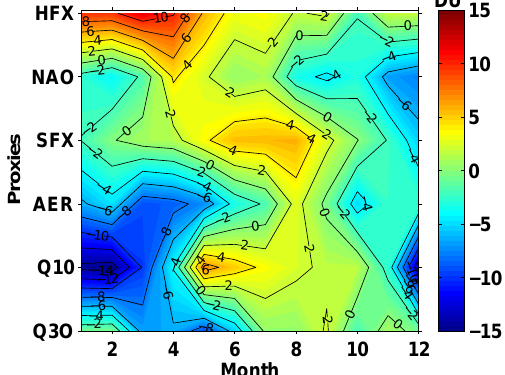
Fig. 2. The influence of individual explanatory variables on the vari- ability of combined Dobson and SAOZ total column ozone data analysed using the EESC-based model. The Q30 and Q10 represent QBO 30 and QBO 10, respectively.